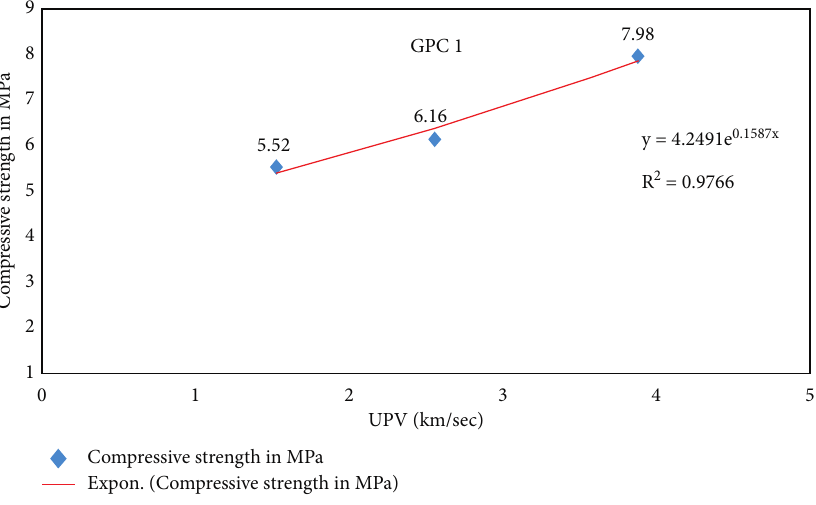
Figure 8: Relation between compressive strength and UPV for GPC 1.